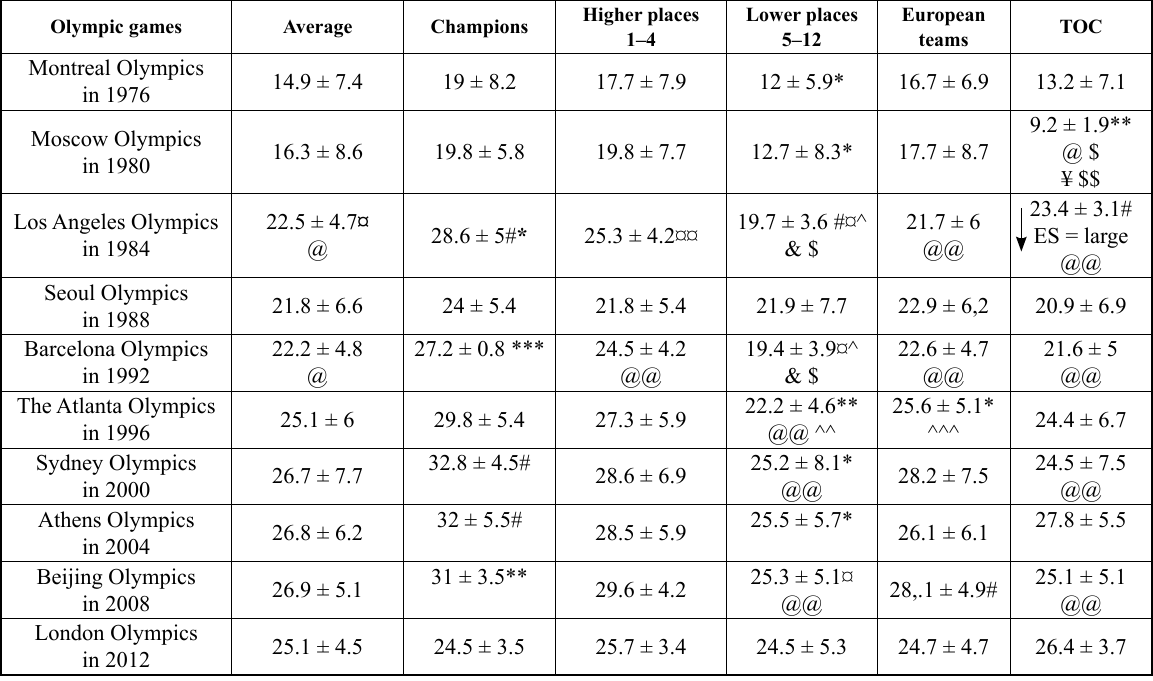
Table 2. Goals scored at the Olympic women’s handball ( x ±